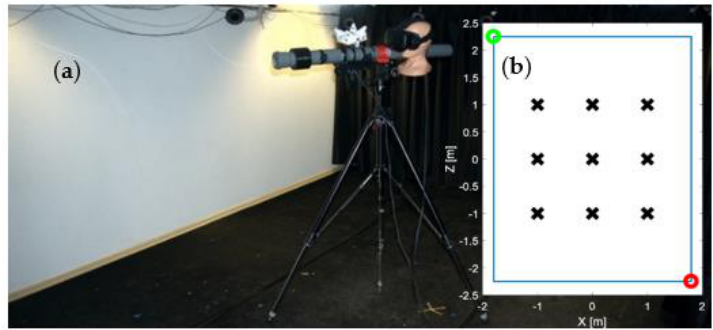
Figure 2. Photo of the laboratory room with a tracker and a model of the launcher on a tripod ( a ); and diagram of the distribution of the measuring points (“x” symbols) ( b ). The blue line marks the walls of the room, and the red and green circles symbolise the base stations.